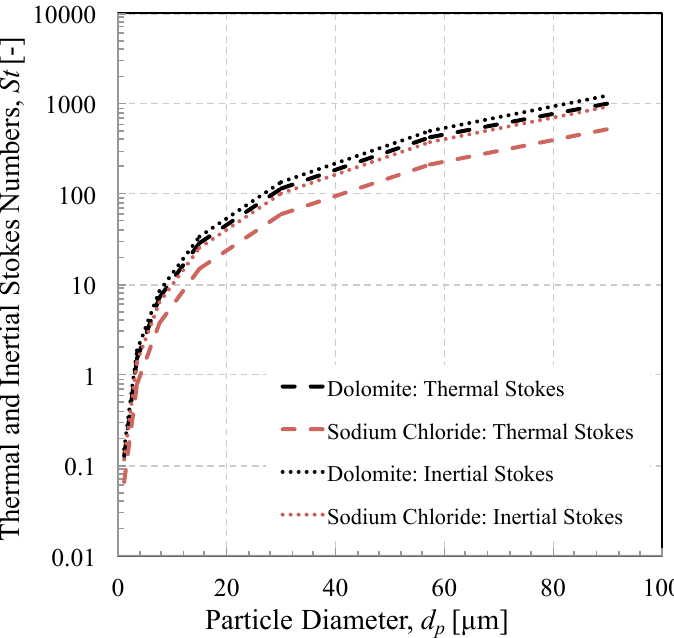
Figure 10. Variation of thermal and inertial stokes number as a function of particle diameter for two